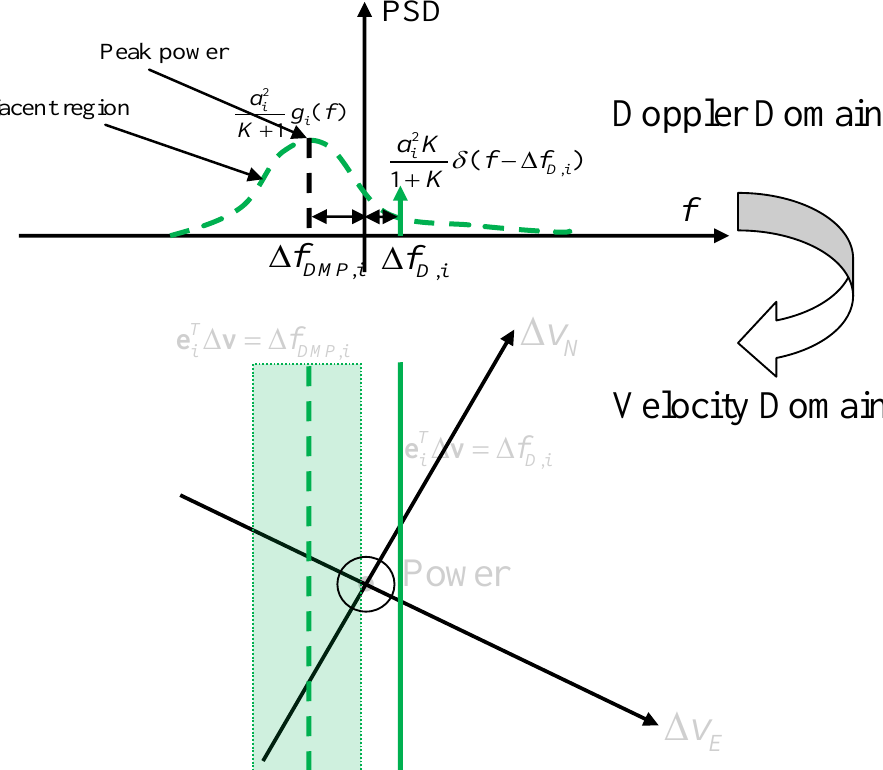
Figure 3. Power projection from Doppler domain to velocity domain (2D